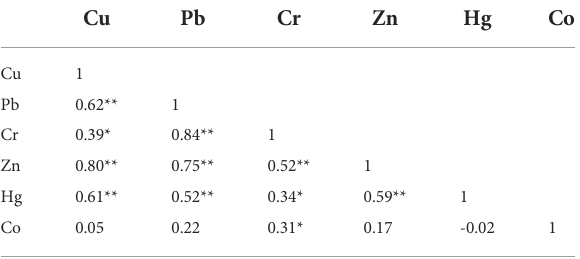
TABLE 5 Factor analysis conducted for the mangrove sediments.